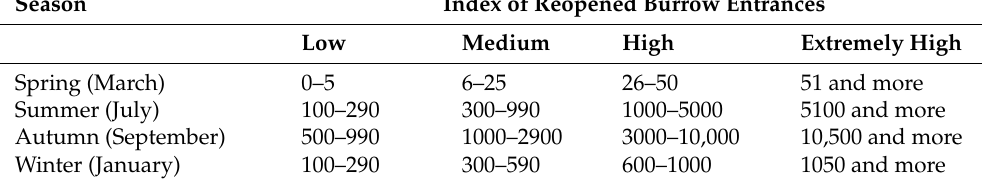
Table 3. Classification of the common vole densities evaluated per 1 hectare, according to the norm [71] effective from 1964.